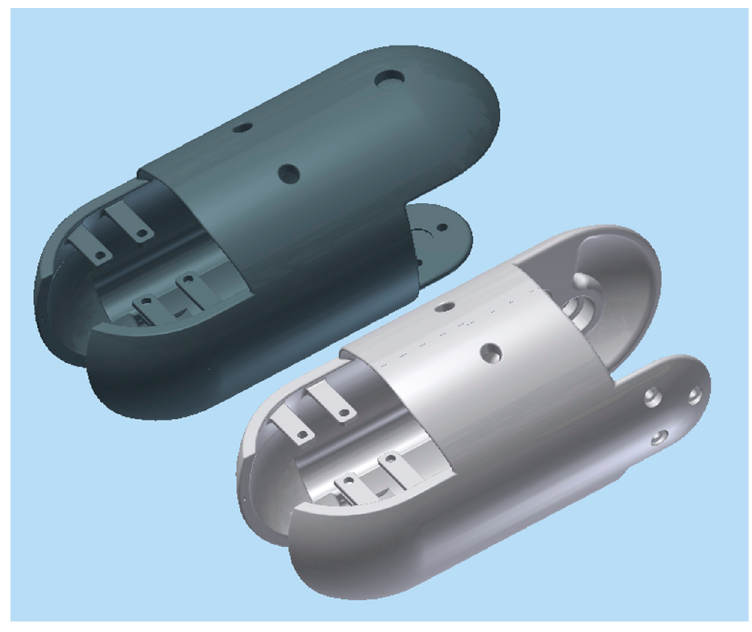
Figure 7. Rotated assembly joint by 90°.